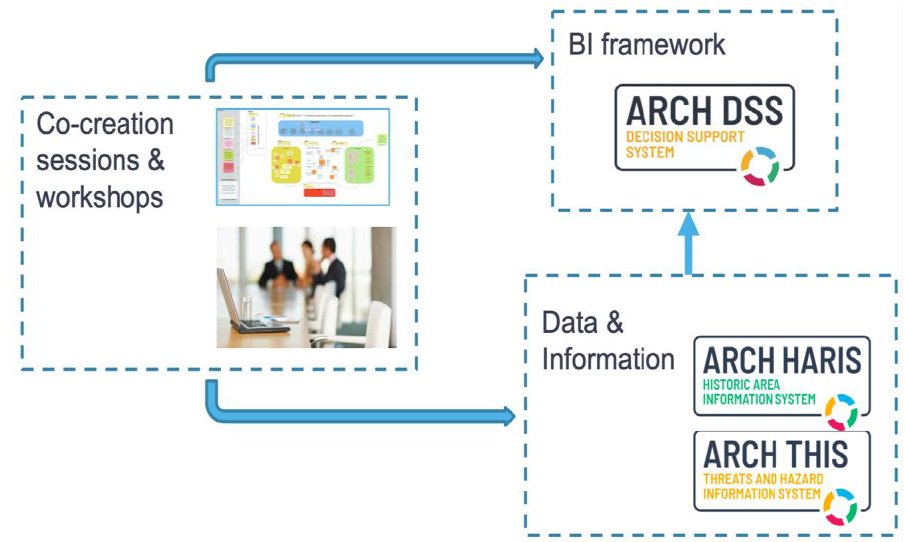
Figure 2. ARCH DSS agile development model, encompassing co-creation activities, ARCH HArIS and THIS and the ARCH DSS hosted in a low-code environment for business intelligence. The individual steps of the development method are detailed in the following